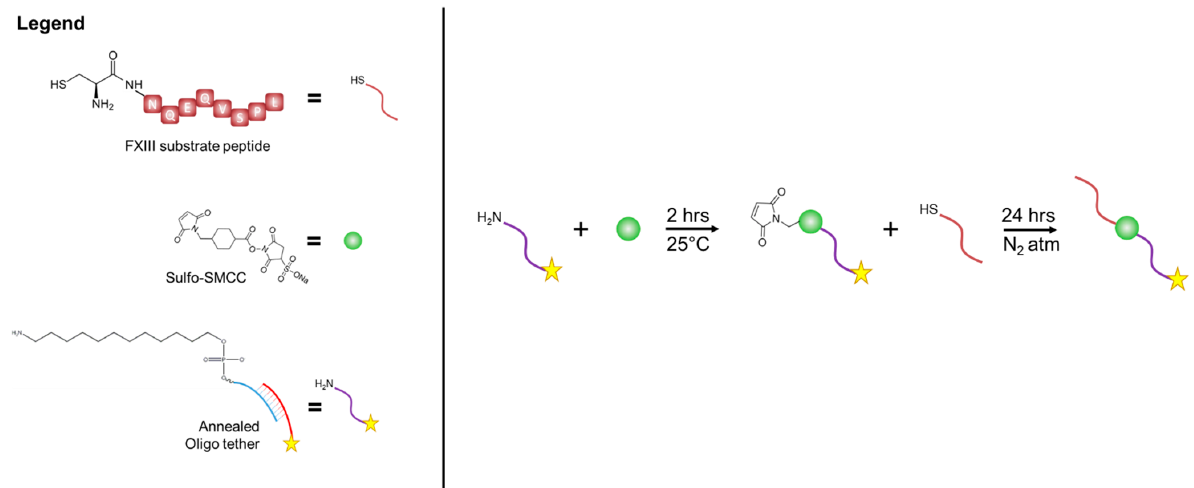
Figure 1. Oligonucleotide–peptide conjugate reaction scheme. The amine-modified parent oligo is first reacted with the N-hydroxysuccinimide ester on the heterobifunctional crosslinker: sulfo-SMCC. The FXIII substrate peptide containing a thiol group via the addition of cysteine residues was then reacted with the maleimide group on the sulfo-SMCC crosslinkers attached to the annealed oligo.